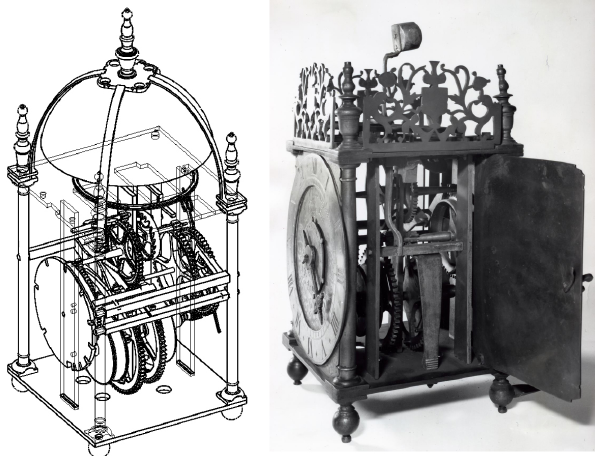
Figure 21. N8 – Lantern clock (Peter Closon) (British Museum, 2020e).